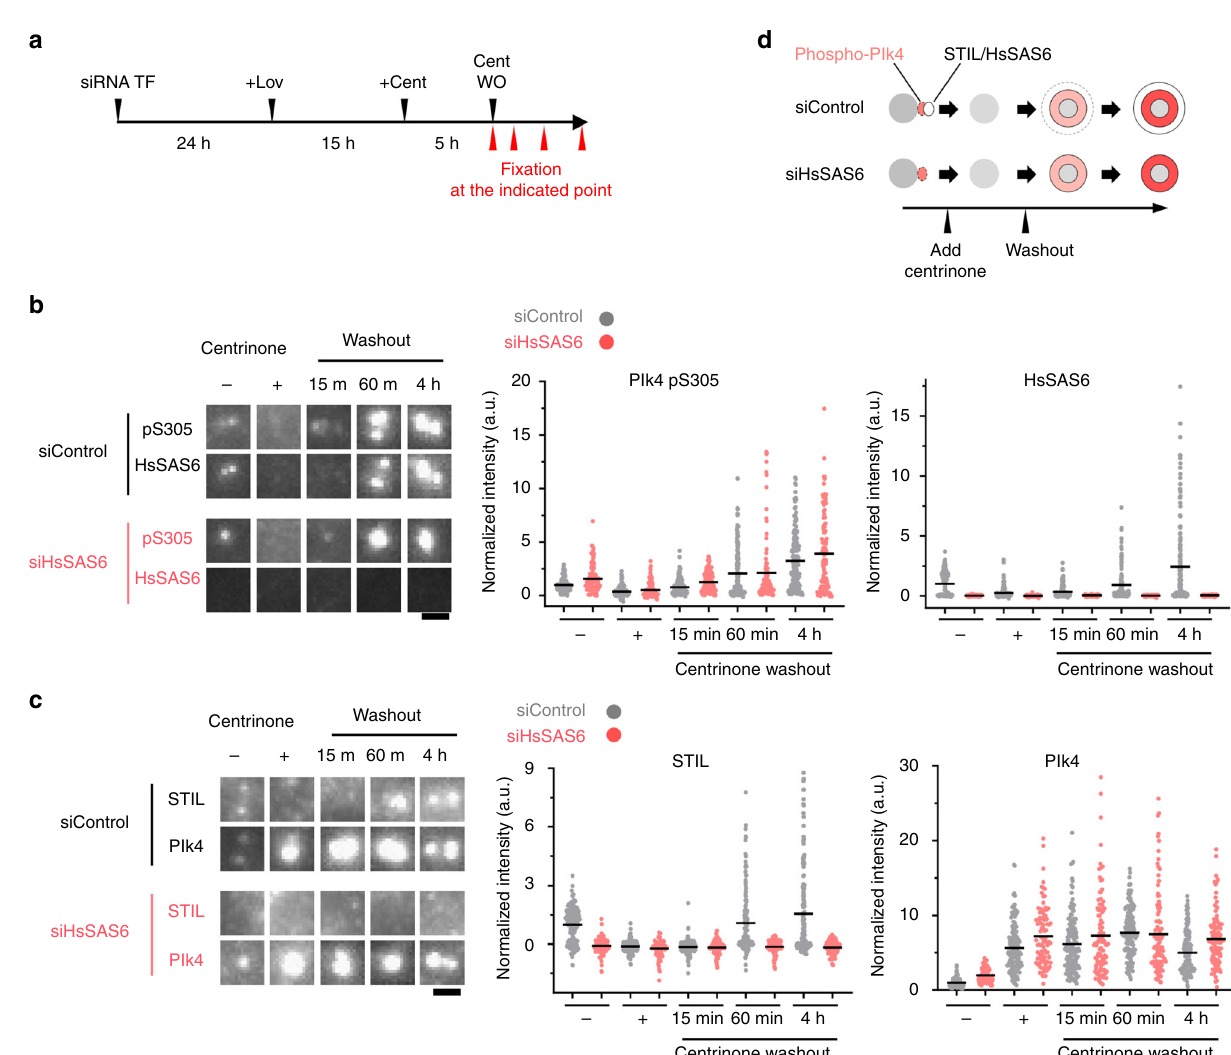
Fig. 5 Autonomous activation of Plk4 that stems from Plk4 self-condensation drives centriolar loading of STIL-HsSAS6. a Scheme of the experimental condition. G1-arrested HeLa cells (10 μ M Lovastatin (Lov) (see also Supplementary Fig. 11)) were treated with 100 nM centrinone (Cent) and then washed out (WO) the centrinone. Cells were continuously treated with Lovastatin after centrinone washout. b , c Representative images of immunostained HsSAS6 and Plk4pS305 ( b ), STIL and Plk4 ( c ) in the indicated condition. Scale bar, 1 μ m. Quanti fi cation data show centriolar Plk4pS305, HsSAS6, STIL, and Plk4 intensities in the indicated condition. Gray and pink dots represent the data from siControl and siHsSAS6-treated cells, respectively. Black bars show mean values (for Plk4pS305 and HsSAS6: siControl n = 166, 161, 171, 154, and 160 centrioles, siHsSAS6 n = 102, 105, 118, 100, and 111 centrioles) (for STIL and Plk4: siControl n = 152, 141, 138, 144, and 138 centrioles, siHsSAS6 n = 109, 96, 104, 105, and 102 centrioles) from two independent experiments. Intensities were normalized to the average intensity of the siControl Centrinone ( − ) condition. d Schematic summary of the correlation between centriolar phospho-Plk4 (pS305) and STIL-HsSAS6 intensity. Source data are provided as a Source Data fi